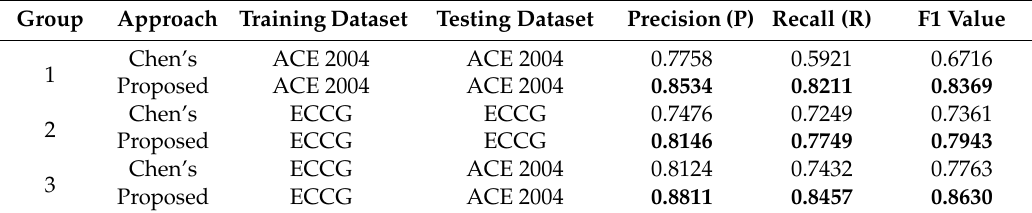
Table 3. Toponym recognition results of two different toponym recognition approaches on different training and testing